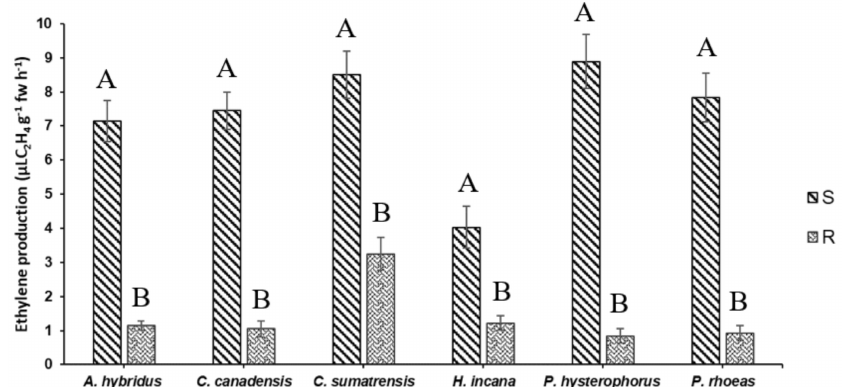
Figure 1. Ethylene production induced by 2,4-D at 480 g ai ha − 1 in di ff erent dicotyledonous weed species resistant (R) and susceptible (S) populations. Means followed by the same letter within each species do not di ff er by the Tukey test ( p < 0.05). Vertical bars are means ± the standard errors of the mean (n =